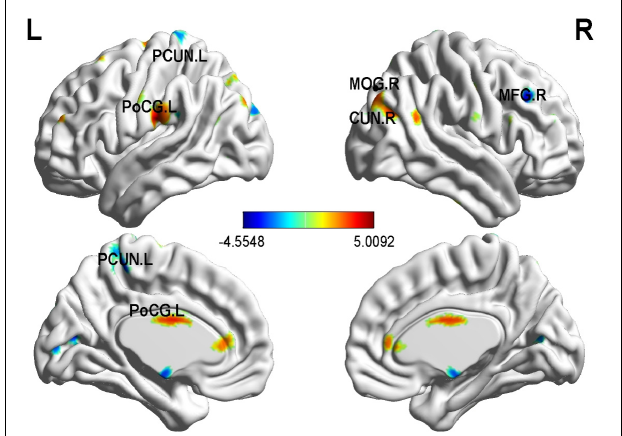
FIGURE 3 | Correlation between whole-brain gray matter volume (GMV) and PDSS scores in PD patients. The left PCUN, the right middle frontal gyrus, and the right cuneus were negatively correlated with PD severity. In contrast, the right MOG, the left PoCG, the left ACG were positively correlated with PD severity. p < 0.01; N =